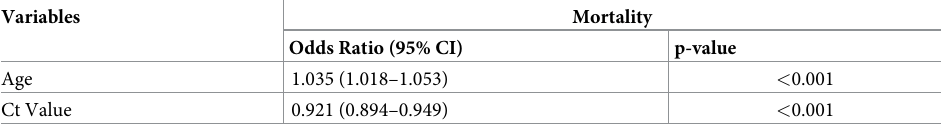
Table 3. Multiple logistic regression of independent predictors of in-hospital mortality using age and viral load as continuous